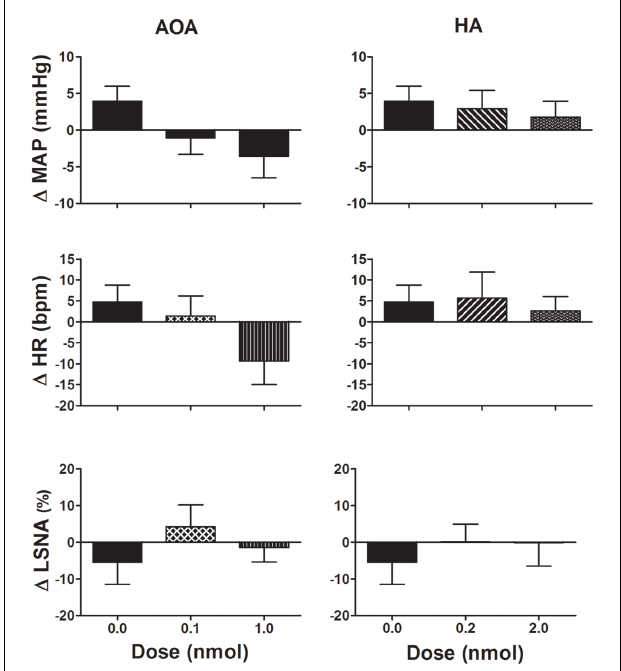
FIGURE 2 | Changes in mean arterial pressure (MAP), heart rate (HR), and lumbar sympathetic nerve activity (LSNA) following vehicle ( n = 13 for MAP and HR and n = 6 for LSNA) and amino-oxyacetate (AOA; 0.1–1.0nmol/side) and hydroxylamine (HA; 0.2–2.0nmol/side; n = 8 for MAP and HR; and n = 5 for LSNA) microinjected into the rostral ventrolateral medulla inWKY rats. AOA and HA are inhibitors of the enzyme cystathionine- β -synthase. Different shaded bars represent a different dose of drug as